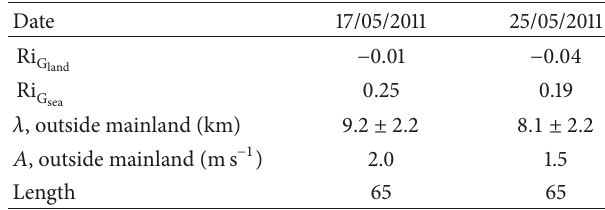
Table 3: Meteorological conditions and roll characteristics during two days from SAR images and met